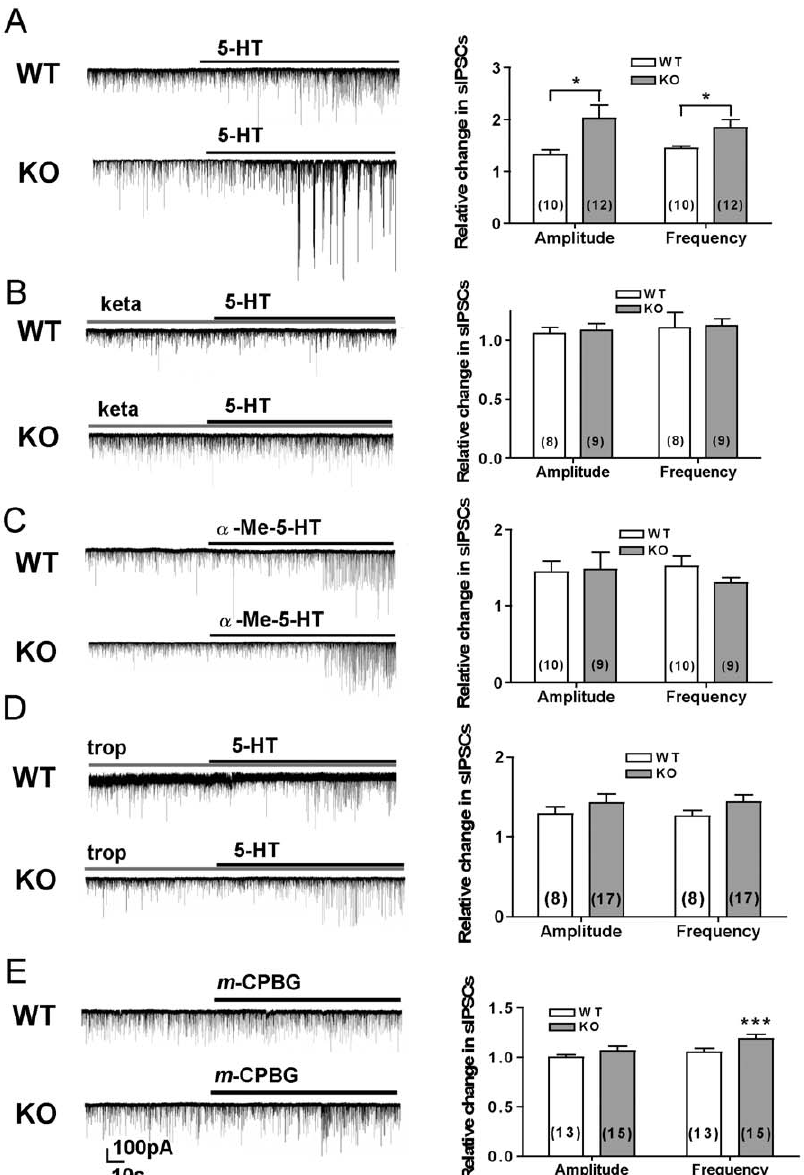
Figure 2. Enhancement of 5-HT-induced sIPSC in pyramidal neurons of CA1 of KO mice is mediated by 5-HT3 receptors. A–E. Pharmacological modulation of sIPSC. Left: Examples of sIPSC traces. Right: summary data. sIPSC modulation by 20 m M 5-HT (A), by 5-HT in the presence of 20 m M 5-HT2 receptors antagonist ketanserin (keta) (B), by 20 m M 5-HT2 receptors agonist a -methyl-5-HT ( a -Me-5-HT) (C), by 5-HT in the presence of 30 nM 5-HT3 receptor antagonist tropisetron (trop) and by 1 m M 5-HT3 receptor agonist m -chlorophenyl biguanide ( m -CPBG). Number of cells recorded from is indicated in parenthesis. *p , 0.05, **p , 0.01. Data represent mean 6 SEM.